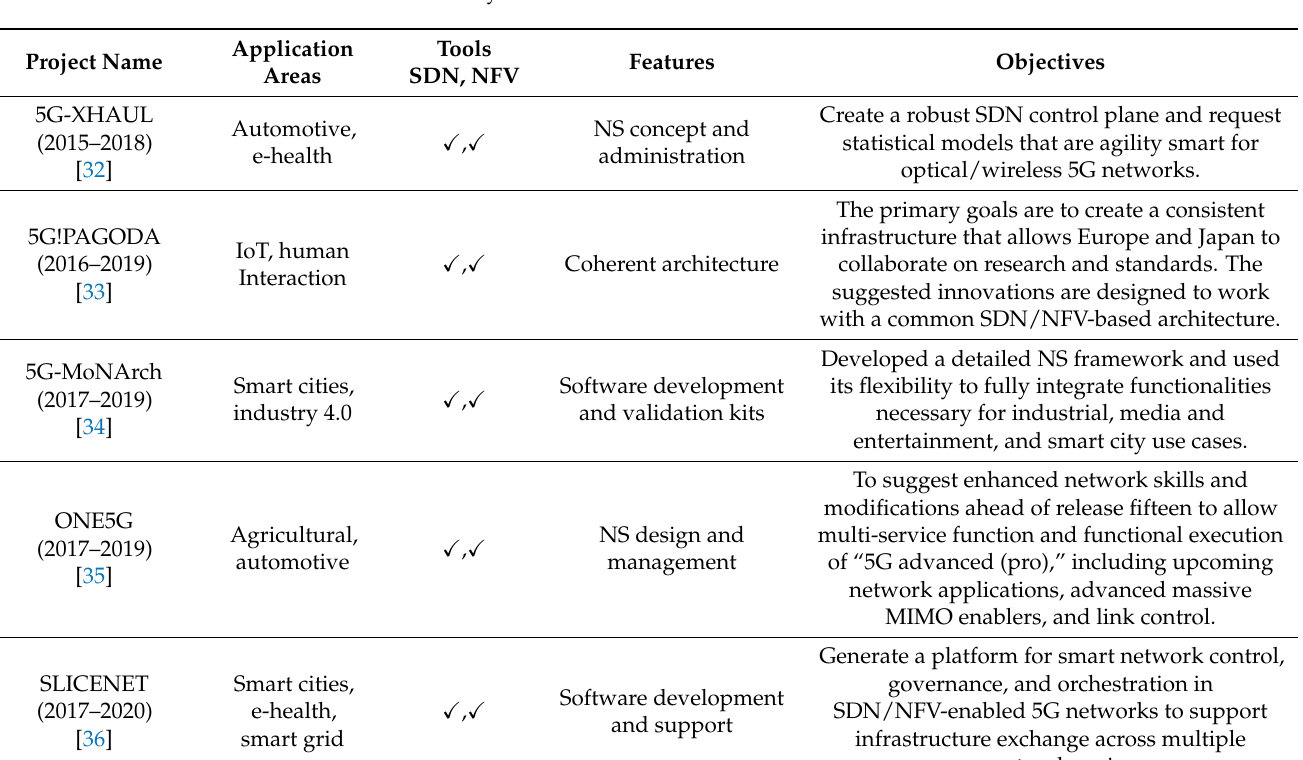
Table 5. Summary of 5G NS initiatives.